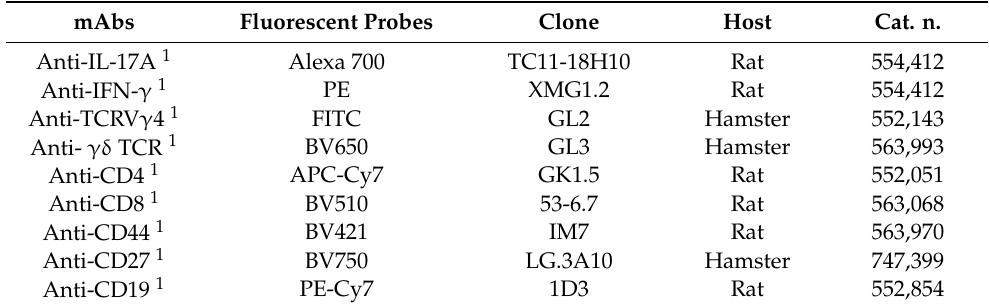
Table 1. Monoclonal antibodies (mAbs) used for immunophenotyping of spleen lymphocytes by flow cytometry. mAbs Fluorescent Probes Clone Host Cat.